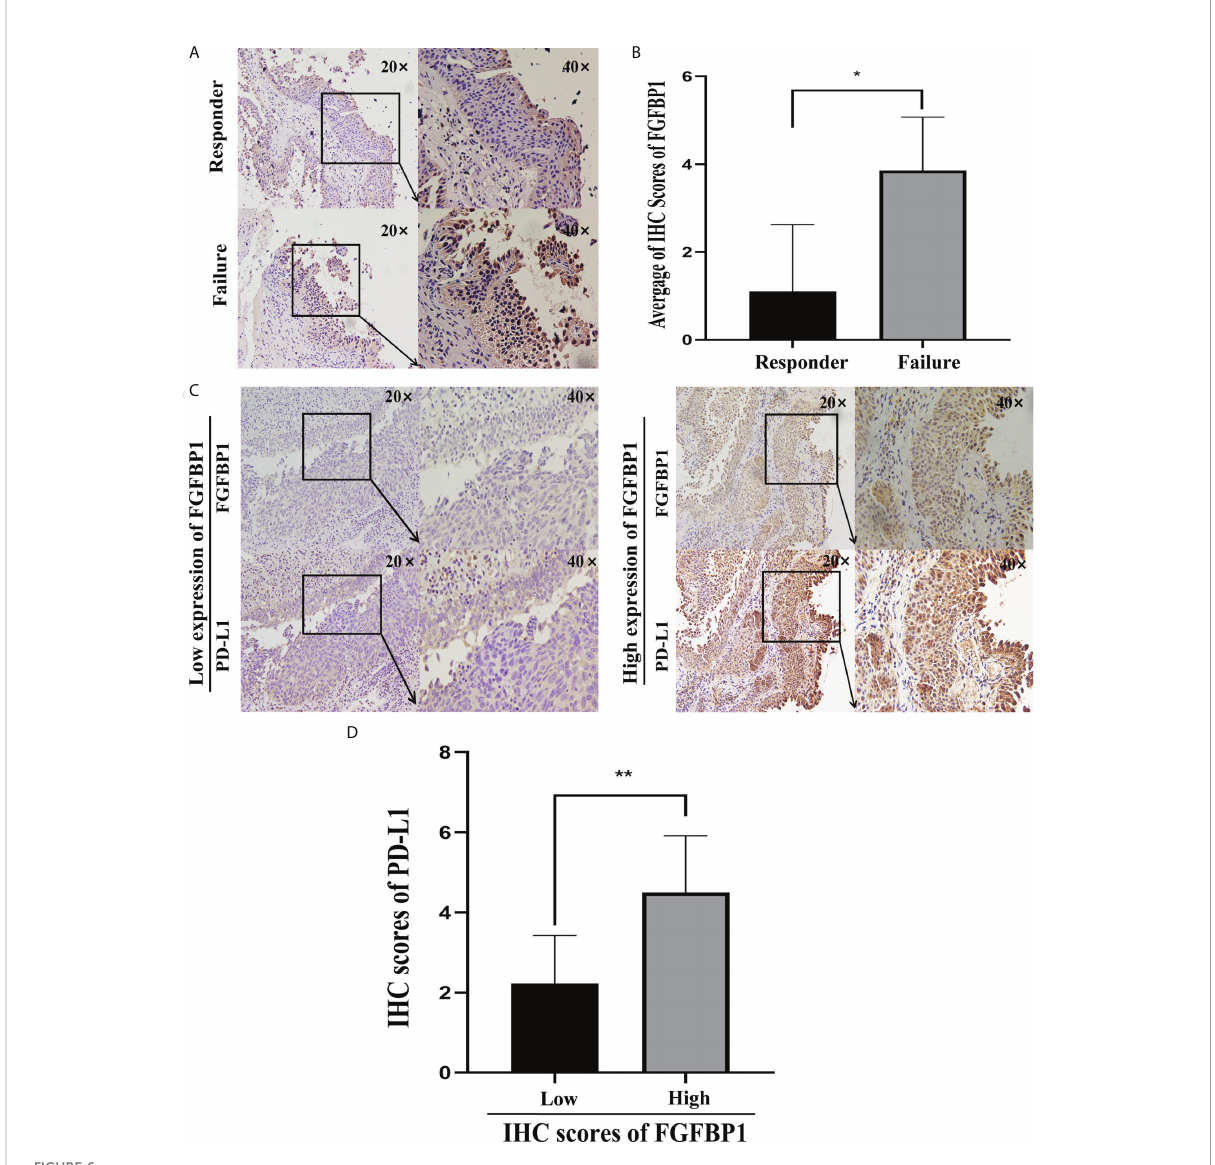
FIGURE 6 FGFBP1 is positively correlated with PD-L1 demonstrated in BCa. (A) FGFBP1 is elevated in failure compared with responders in BCa by immunohistochemical staining. (B) The immunohistochemical staining scores of FGFBP1 are higher in failures than responders in BCa. (C) The expression level of PD-L1 was signi fi cantly higher when FGFBP1 was increased by immunohistochemical staining when the BCG cohorts were divided into FGFBP1 high- and low-expression groups strati fi ed by the median FGFBP1 expression. (D) The immunohistochemical staining scores of PD-L1 are positively associated with FGFBP1. * p < 0.05; ** p <